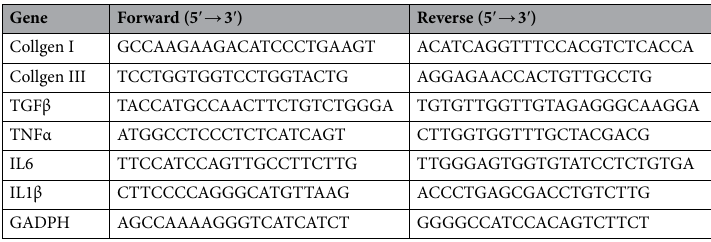
Table 1. Primer sequences employed in RT-qPCR